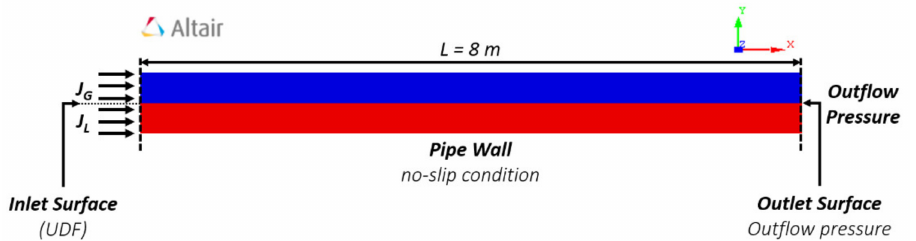
Figure 1. Representation of fluid domain in Altair AcuSolve and the applied boundary